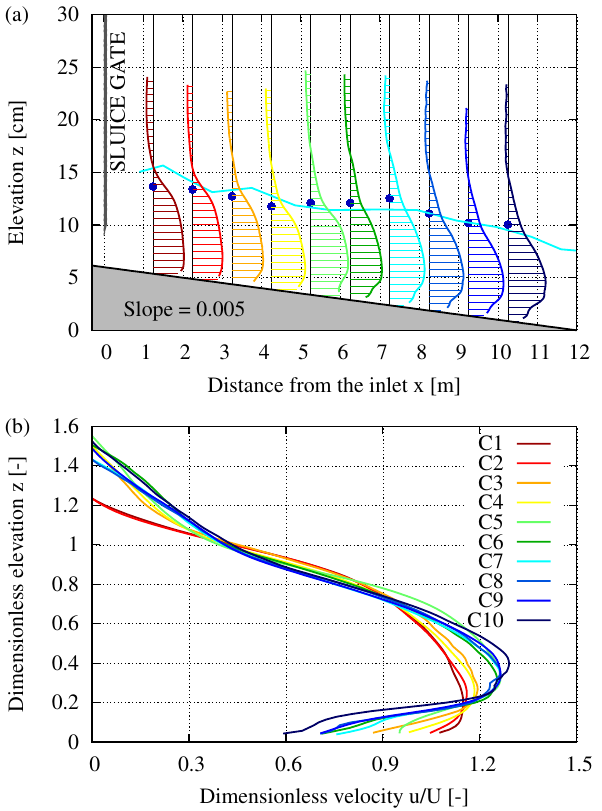
Figure 4. Comparison between the flow height computed integrat- ing the longitudinal velocity profile (red line) with di ff erent upper limit of integration (0-0.1-0.2-0.3-0.4-0.5U) and the flow interface extracted visually (blue line) from the lateral sidewall (Experiment S4 - section C5). The crosses are located at heights corresponding to the flow thickness computed employing di ff erent values of the upper bound of integration.